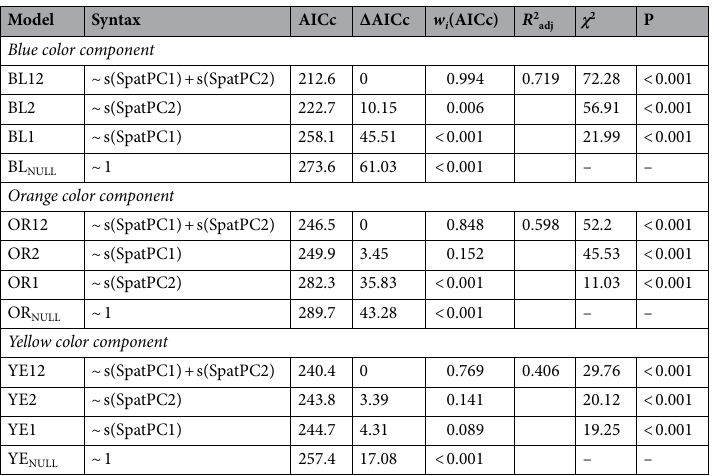
Table 2. Effects of climate on the occurrence of blue, orange, and yellow color components on the throat badge of male lizards in the spatial dataset. A series of candidate generalized additive models were used to evaluate the effect of climate (SpatPC1 and SpatPC2) on color component frequency. Nagelkerke’s R 2 values (adjusted for low sample sizes) are provided for the best-fit model for each color component (i.e., lowest AICc and highest w